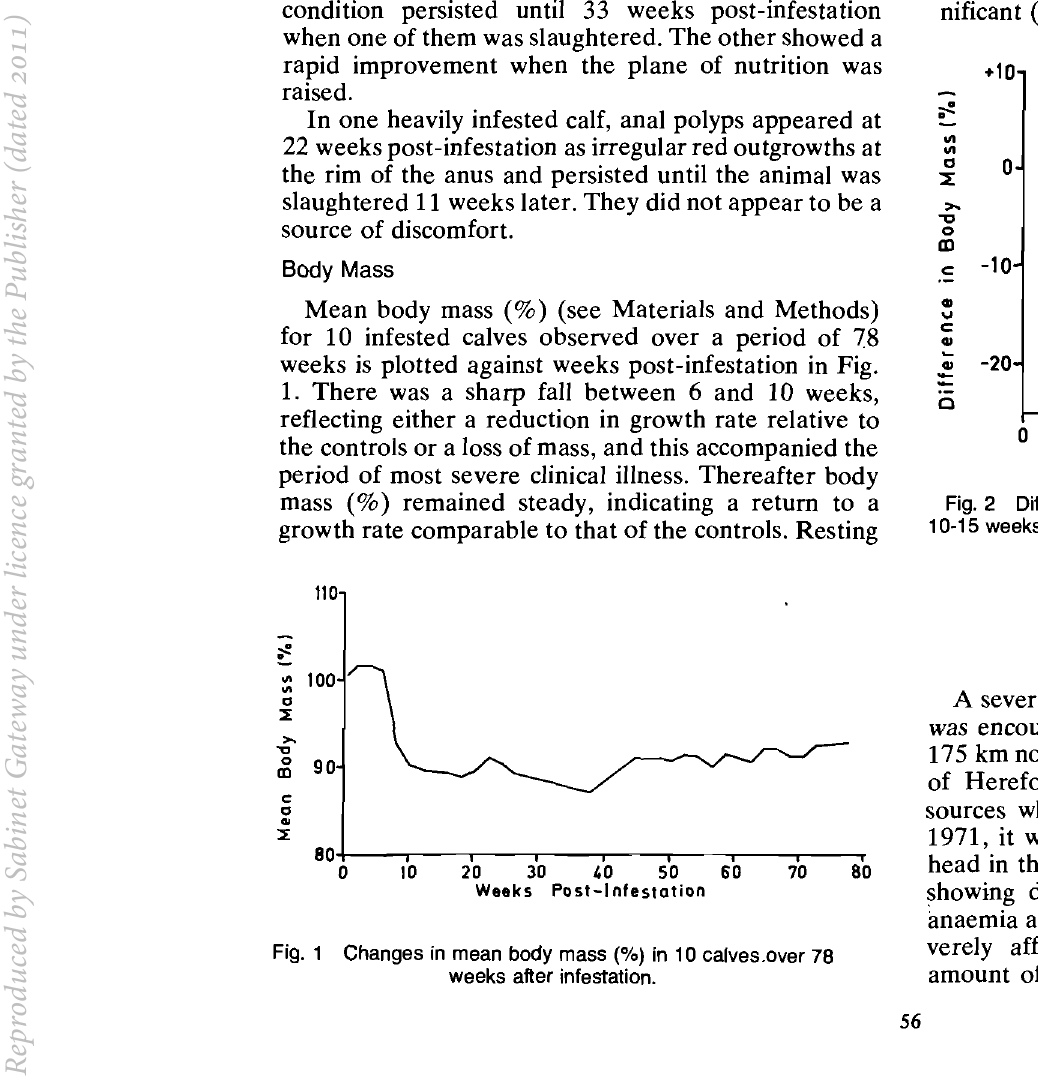
Fig. 2 Difference in body mass (%) between 0-5 weeks and 10-15 weeks post-infestation in calves on two planes of nutrition.